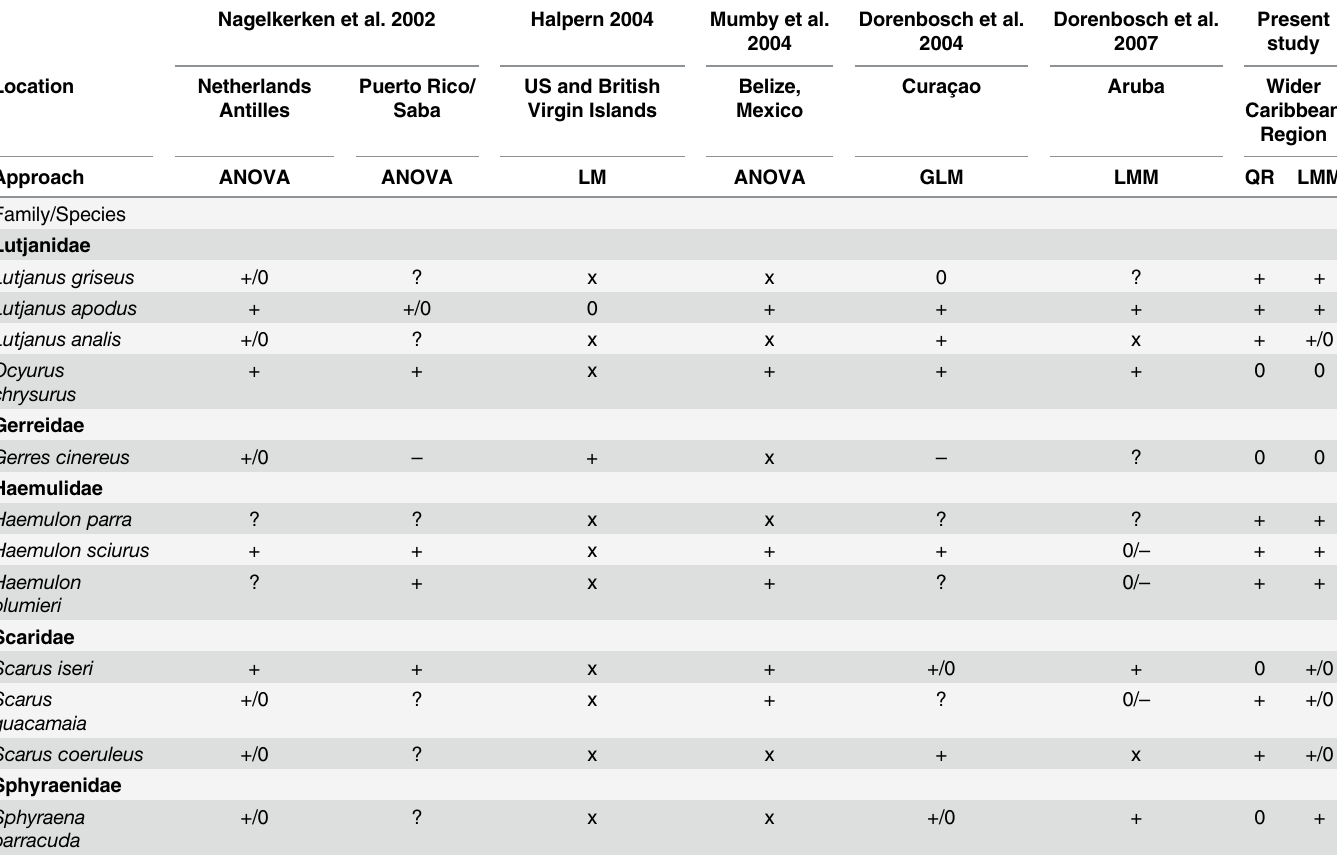
Table 3. Reef fish abundance in relation to mangrove extent. Comparison of present study findings (and analysis methodology) with those of previous studies investigating reef fish abundance in relation to mangrove forests in the Wider Caribbean Region. ANOVA = analysis of variance, LM = linear model, GLM = generalized linear model, LMM = linear mixed model, QR = quantile regression. + = positive relationship with mangroves, – = negative relationship with mangroves, 0 = no relationship with mangroves, letter x indicates fish species was not considered in the analysis, question mark (?) indicates fish spe- cies was included in study but there were not enough data to